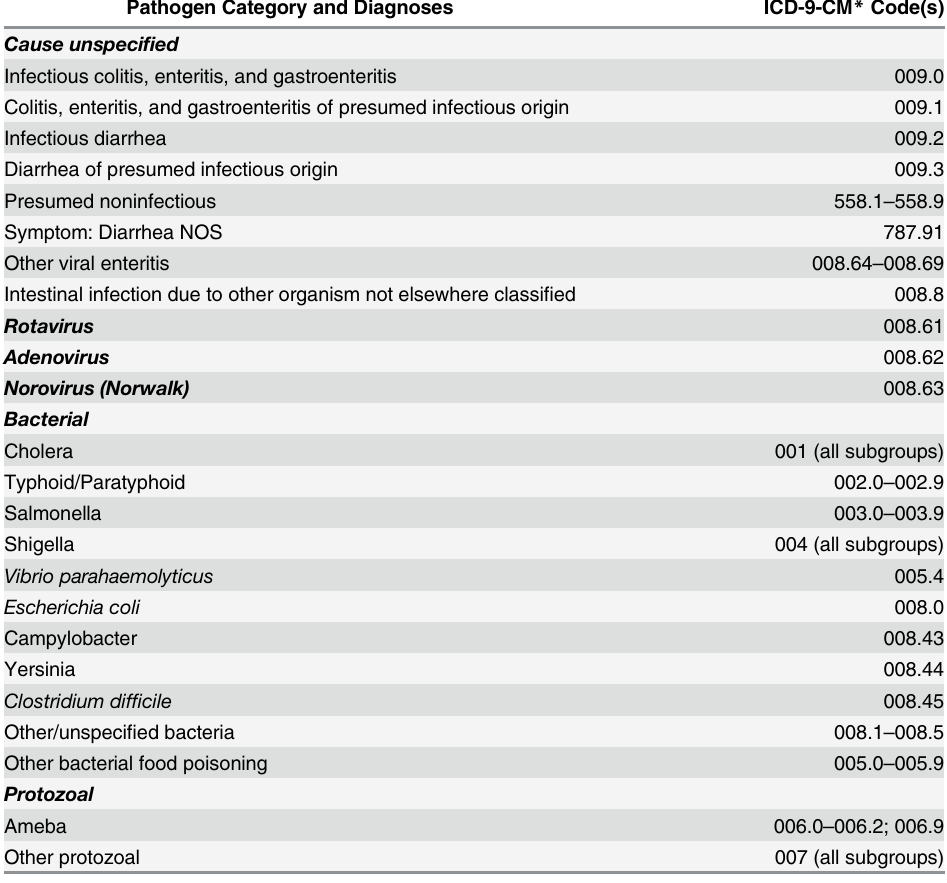
Table 1. Pathogen-based categories of diagnostic codes used to identify gastroenteritis-associated medical encounters, supplied by the United States Armed Forces Health Surveillance Center, July 1998 – June